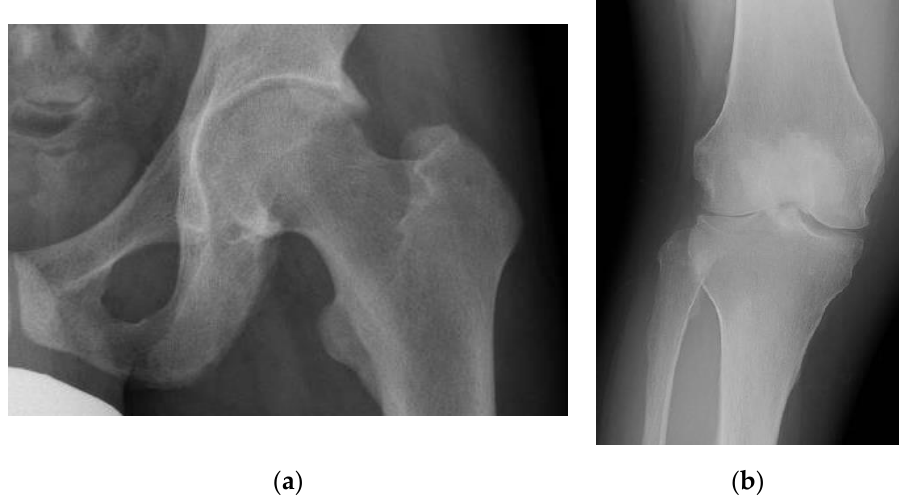
Figure 3. Early osteoarthritis in adult XLH patients. ( a ) Osteoarthritis with a Kellgren – Lawrence grade of 3 in the left hip joint of a 29-year-old male XLH patient. ( b ) Osteoarthritis with a Kellgren – Lawrence grade of 3 in the right knee joint of a 30-year-old female XLH patient.